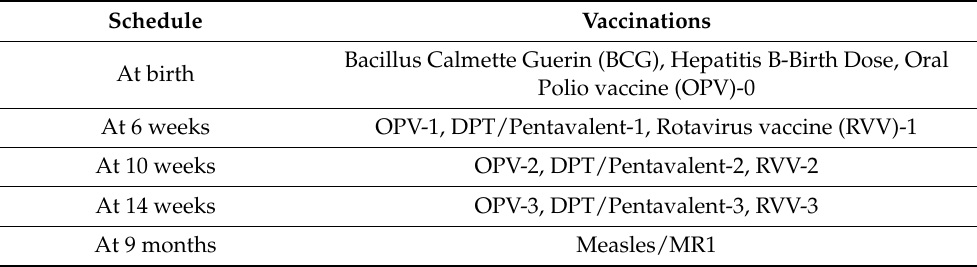
Table 1. The schedule of vaccination in India.